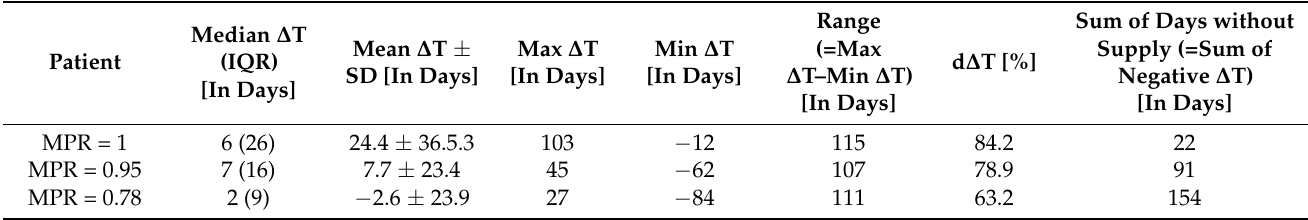
Table 1. Values of ∆ T for the three illustrative